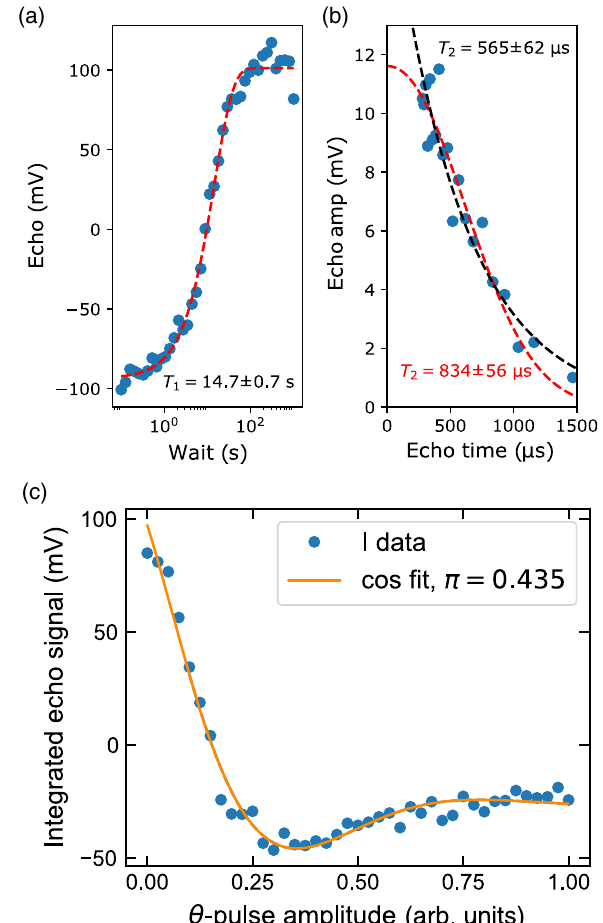
FIG. 10. (a) T 1 by inversion recovery. A WURST pulse is used to invert the ensemble before a wait (indicated on the x axis) and a detection sequence at constant high power and τ . (b) T 2 meas- urement of the sample at the same weak excitation strength as used in Fig. 4. The pulse sequence (inset) is a weak excitation followed by two 100 μ s WURST pulses. Increasing τ changes the echo time allowing T 2 to be measured. Fitting stretched or single exponentials gives different T 2 giving a combined uncertainty of T 2 ¼ 0 . 7 ð 2 Þ ms. (c) Rabi oscillations using a Gaussian θ pulse of duration 8 μ s and FWHM 4 μ s and a two-WURST silenced echo detection sequence. The oscillations are heavily damped due to a large inhomogeneity in Rabi frequency across the